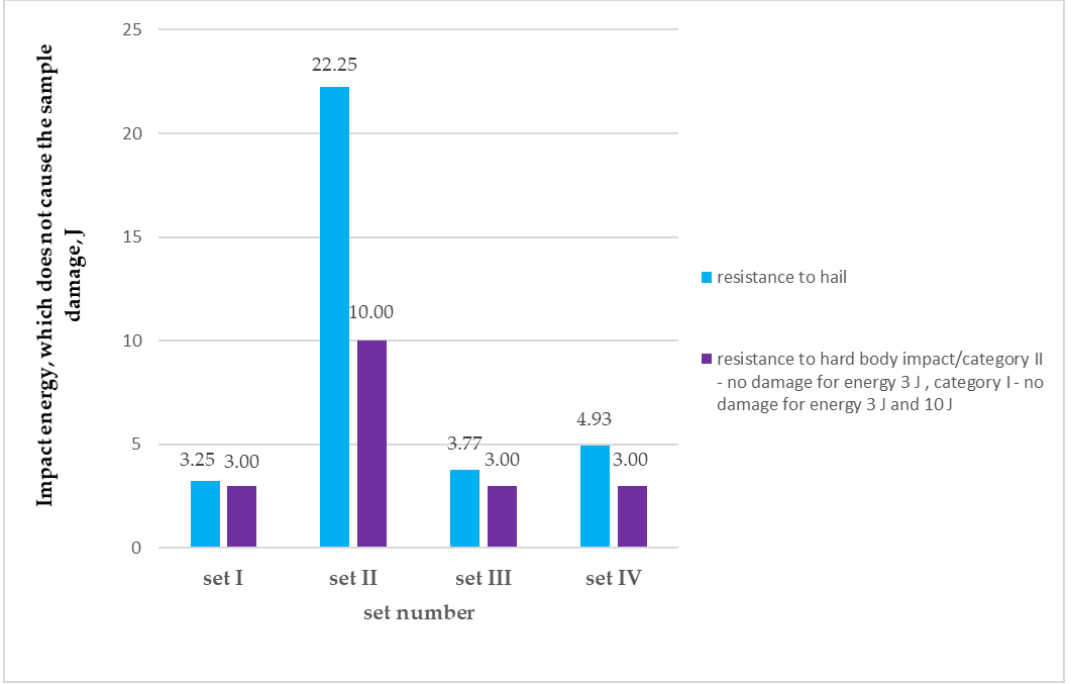
Figure 9. Comparison between results of hail resistance test and resistance to hard body impact for ETICS with different adhesives.